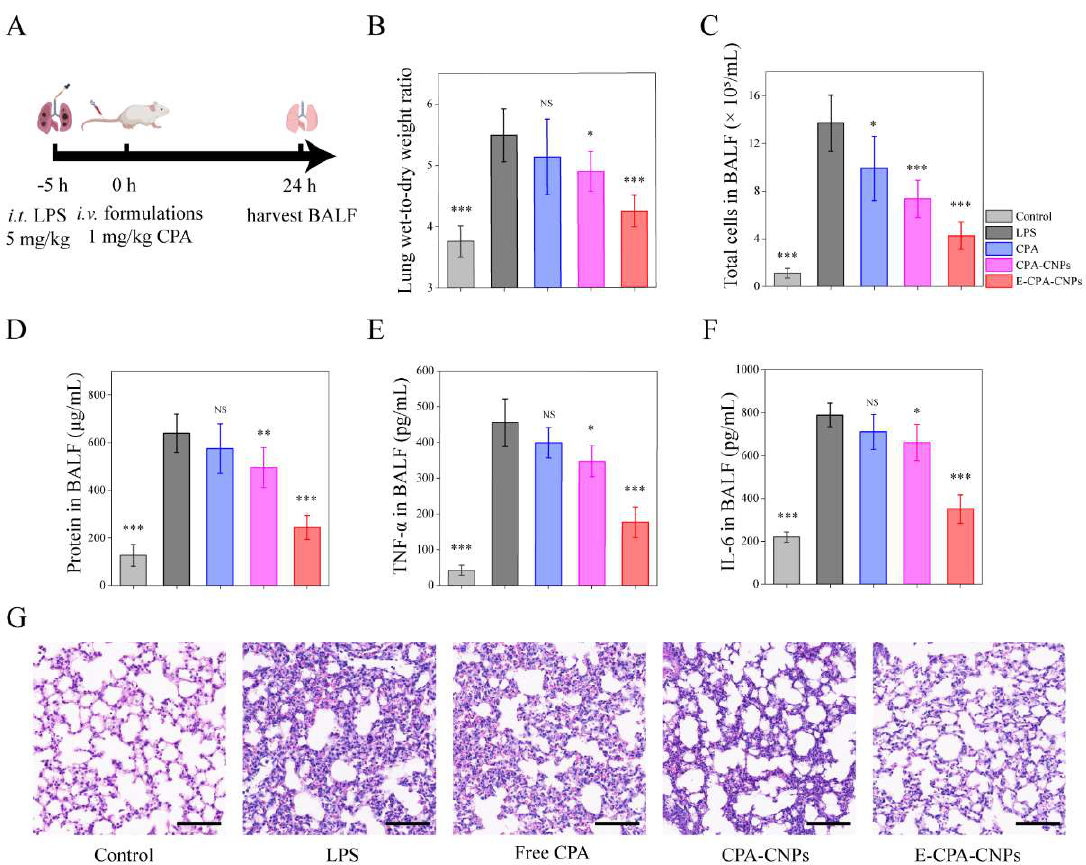
Figure 6. The therapeutic efficiency of E-CPA-CNPs in ALI model mice. ( A ) Schematic illustration for detecting the therapeutic efficiency of free CPA, CPA-CNPs and E-CPA-CNPs (1 mg/kg). ( B ) The lung wet-to-dry weight ratio and ( C ) cell counts in BALF were assessed. ( D ) Measurement of protein content in BALF. The levels of ( E ) TNF-α and ( F ) IL-6 in BALF were detected with ELISA kits. ( G ) H&E staining of lung tissue from each experimental group (scale bar = 50 μm). ( n = 5, mean ± SD, * p < 0.05, ** p < 0.01, *** p < 0.001 and NS: non-significance, compared with LPS group).